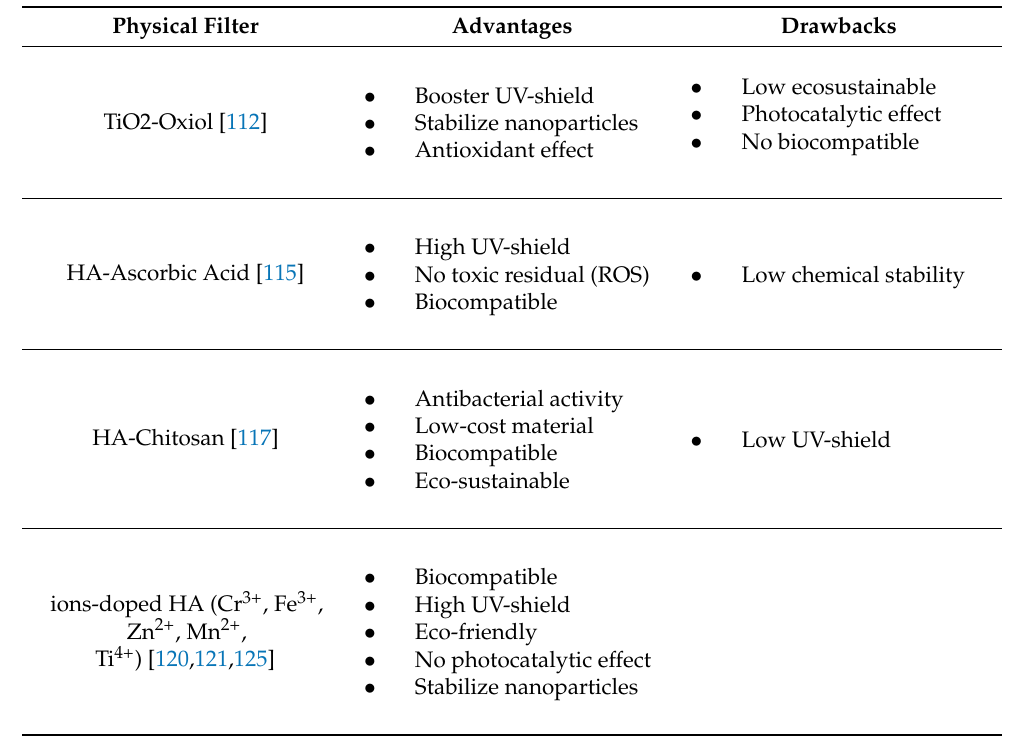
Table 2. Advantages and drawbacks of some physical filters.